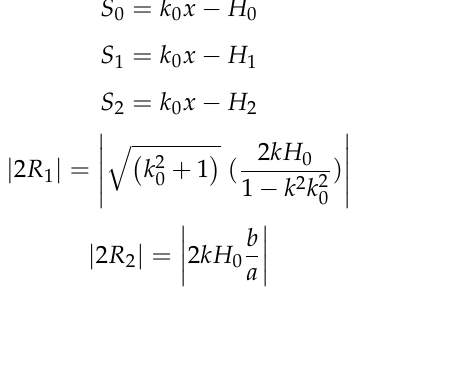
Figure 4. Ellipse seal cone in TOBV and circular seal cone in QOBV. The sections of the QOBV disc ( S i ) in Equations (4)–(6) depend on H i (i = 1, 2, and 3), as shown in Figure 5. ‘ S 1 ’ and ‘ S 2 ’ are the upper and lower sections of the disc, and S 0 is a middle section of the disc center. ‘ H 0 ’ is a displacement of the center of the disc from the origin of coordinates. ‘ H 1 ’ and ‘ H 2 ’ are displacements of the center of the disc top (BC) and bottom (AD) from the origin of coordinates. ‘ N i ’ is the intersection between the cone center, and ‘ S i ’, ‘ k 0 ’ is the substituted for tan γ , and ‘ γ ‘is the offset angle of the axis (z) from the center line of the disc. ‘ S i ’ of TOBV makes an elliptical disc shape, which has a radius of the major axis ( R 1 ) and radius of the minor axis ( R 2 ) in the middle section ( S 0 ), and these are defined by Equations (7) and (8). ‘ α ’ is half of the conical angle in the cone surface, and ‘ k ’ is substituted for tan α